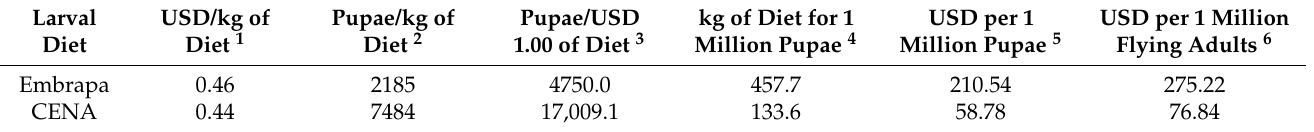
Table 5. Data of productivity and cost of the two larval diets tested for the Vacaria strain of Anastrepha fraterculus . Larval